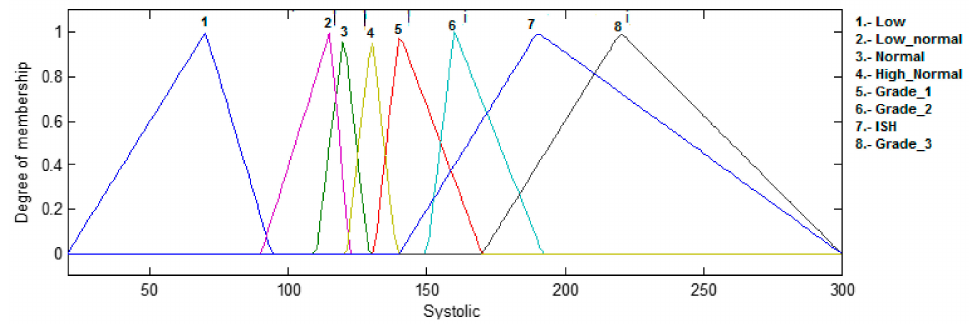
Figure 4. Systolic input for the fuzzy logic classifier 1.